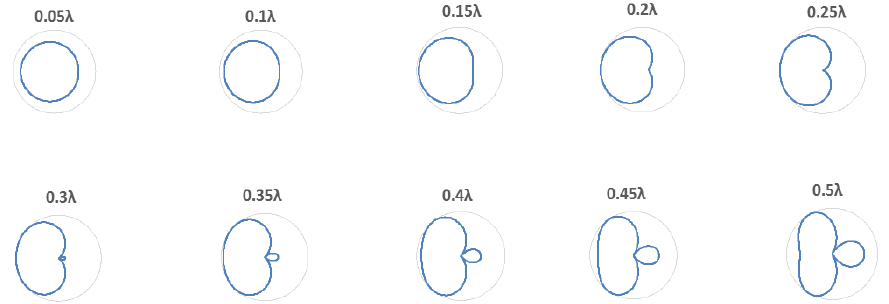
Figure 3. Radiation patterns of two isotropic sources spaced from 0.05 λ to 0.5 λ with a 90 ° phase difference feed.